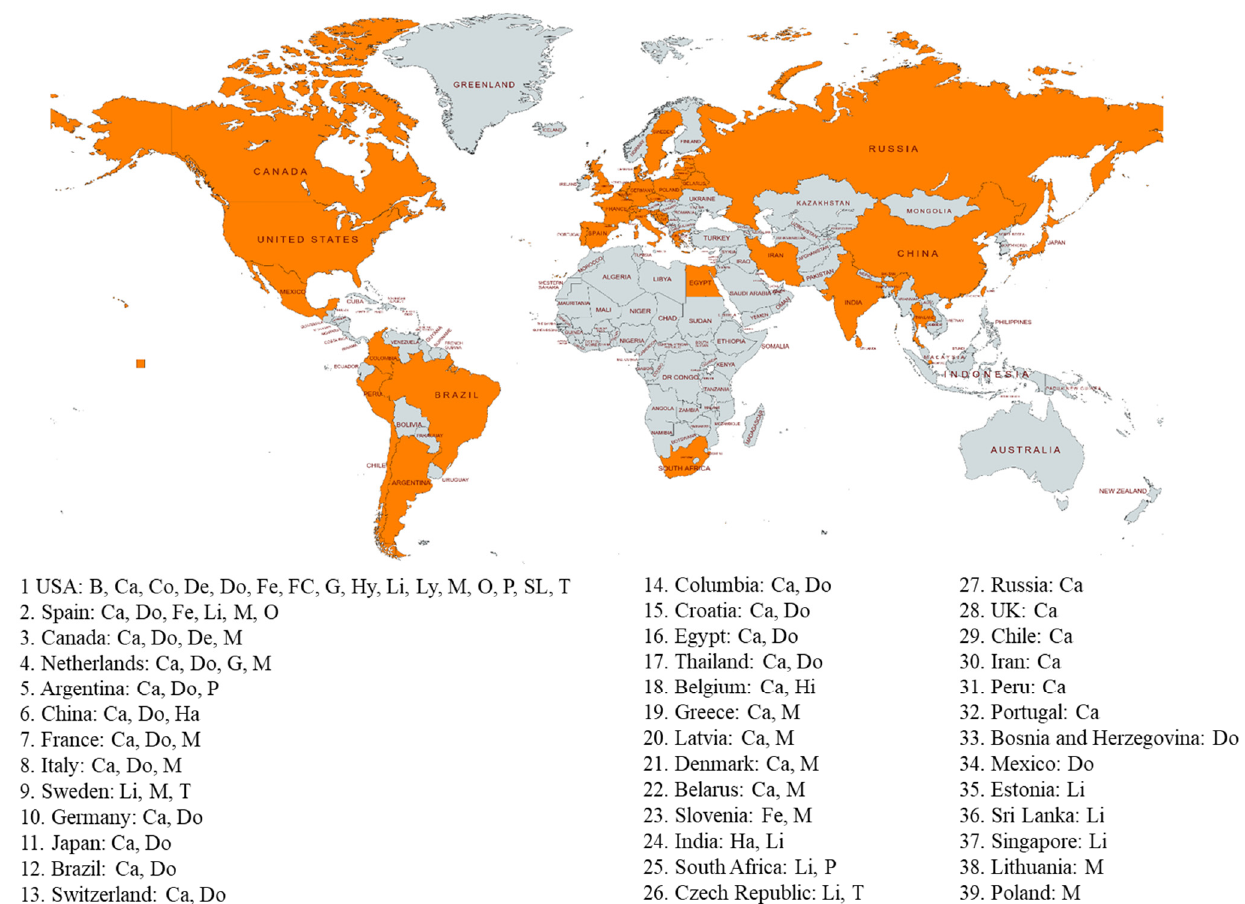
Figure 2. Countries with positive SARS-CoV-2 animals are marked with orange color. Animal species positive for SARS-CoV-2 in each country are provided. Until 12 May 2022, a total of 39 countries had animals that tested positive for SARS-CoV-2. B: binturong; Ca: cat; Co: coatimundi; De: deer; Do: dog; Fe: ferret; FC: fishing cat; G: gorilla; Ha: hamster; Hi: Hippo; Hy: hyena; Li: lion; Ly: lynx; M: mink; O: otter; P: puma; SL: snow leopard; T: tiger.